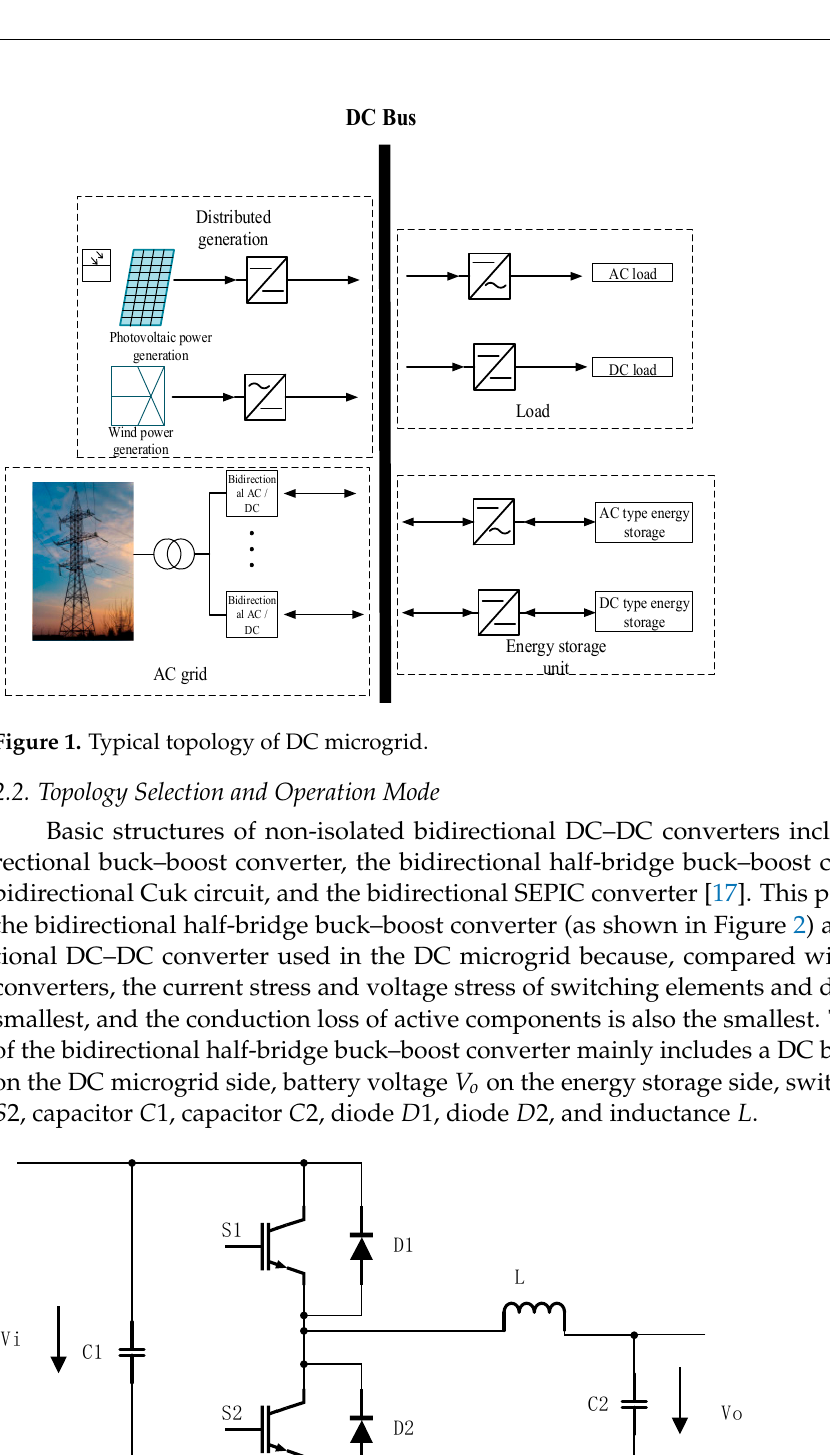
Figure 1. Typical topology of DC microgrid.